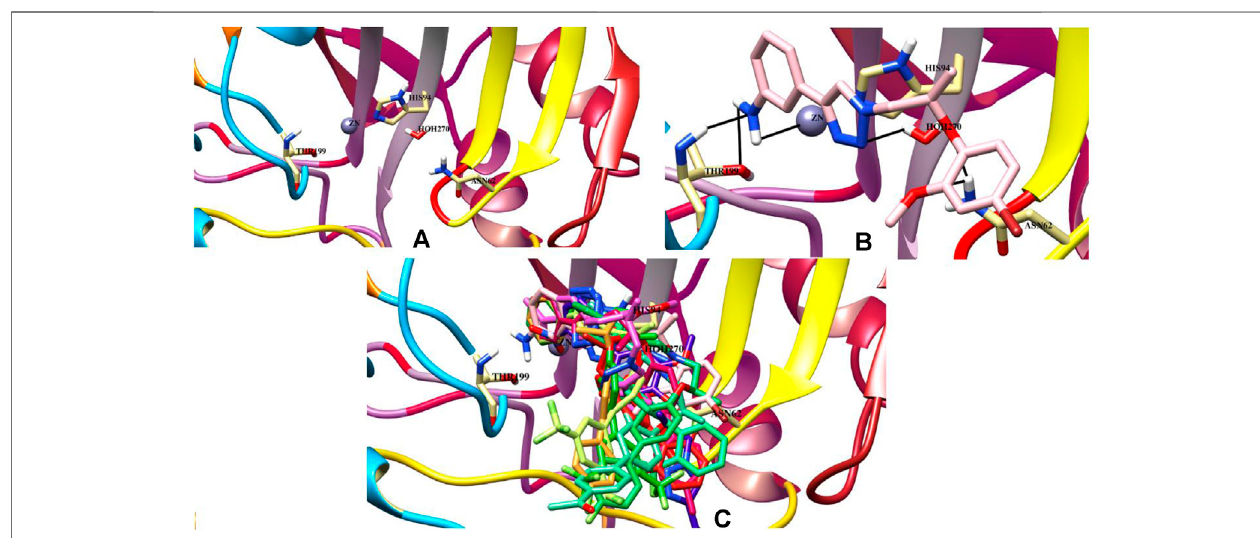
TABLE 2 | In vitro and in silico results of the compounds against carbonic anhydrase-II. Compounds IC 50 ± SEM (µM) Score Binding interaction